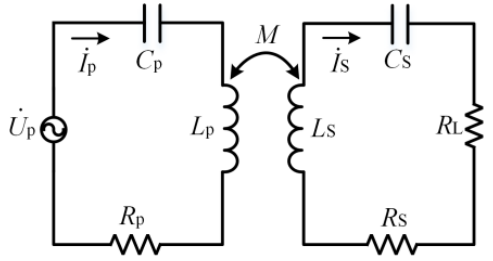
Figure 3. System equivalent circuit diagram.